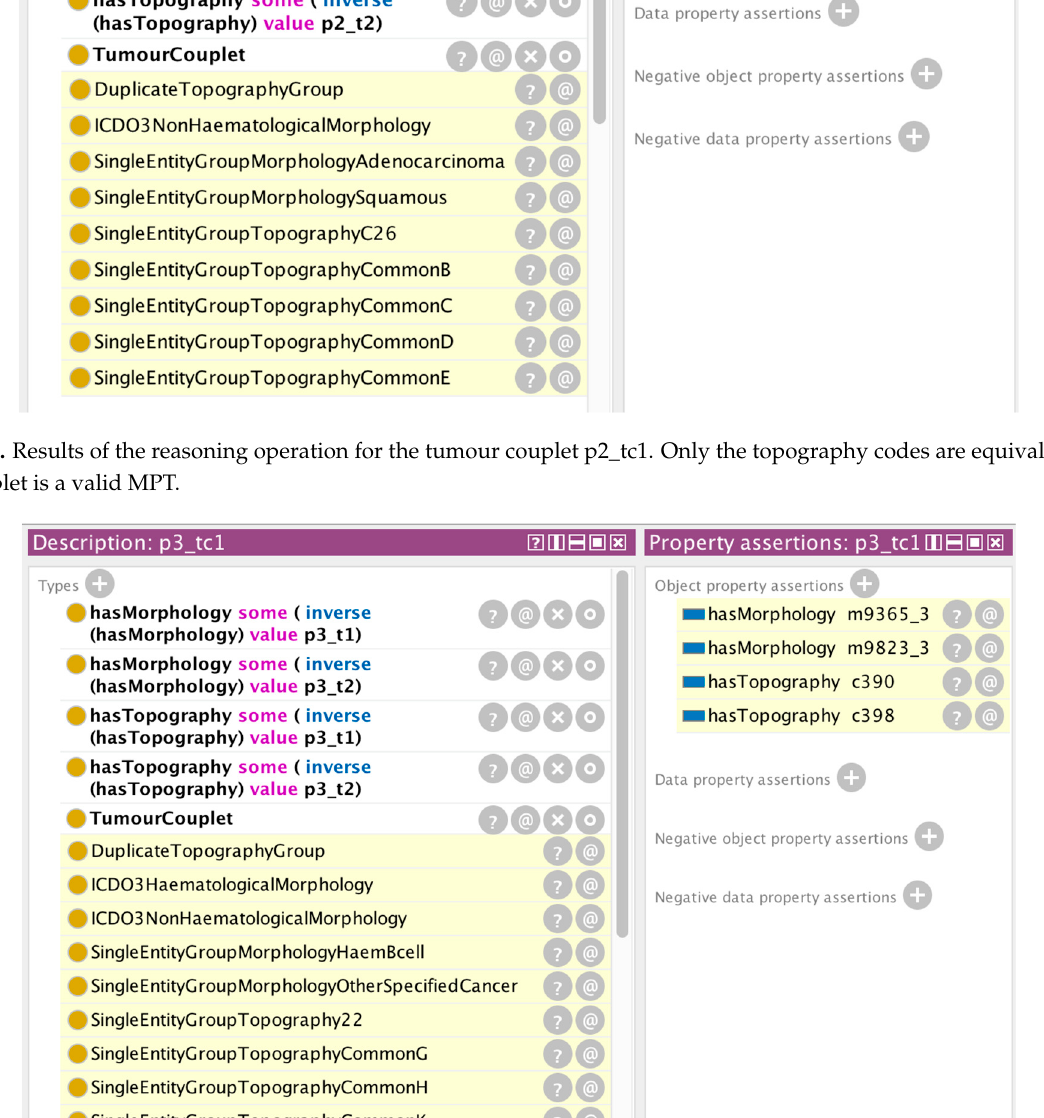
Figure 8. Results of the reasoning operation for the tumour couplet p3_tc1. Only topography codes are equivalent and therefore the couplet is a valid MPT.